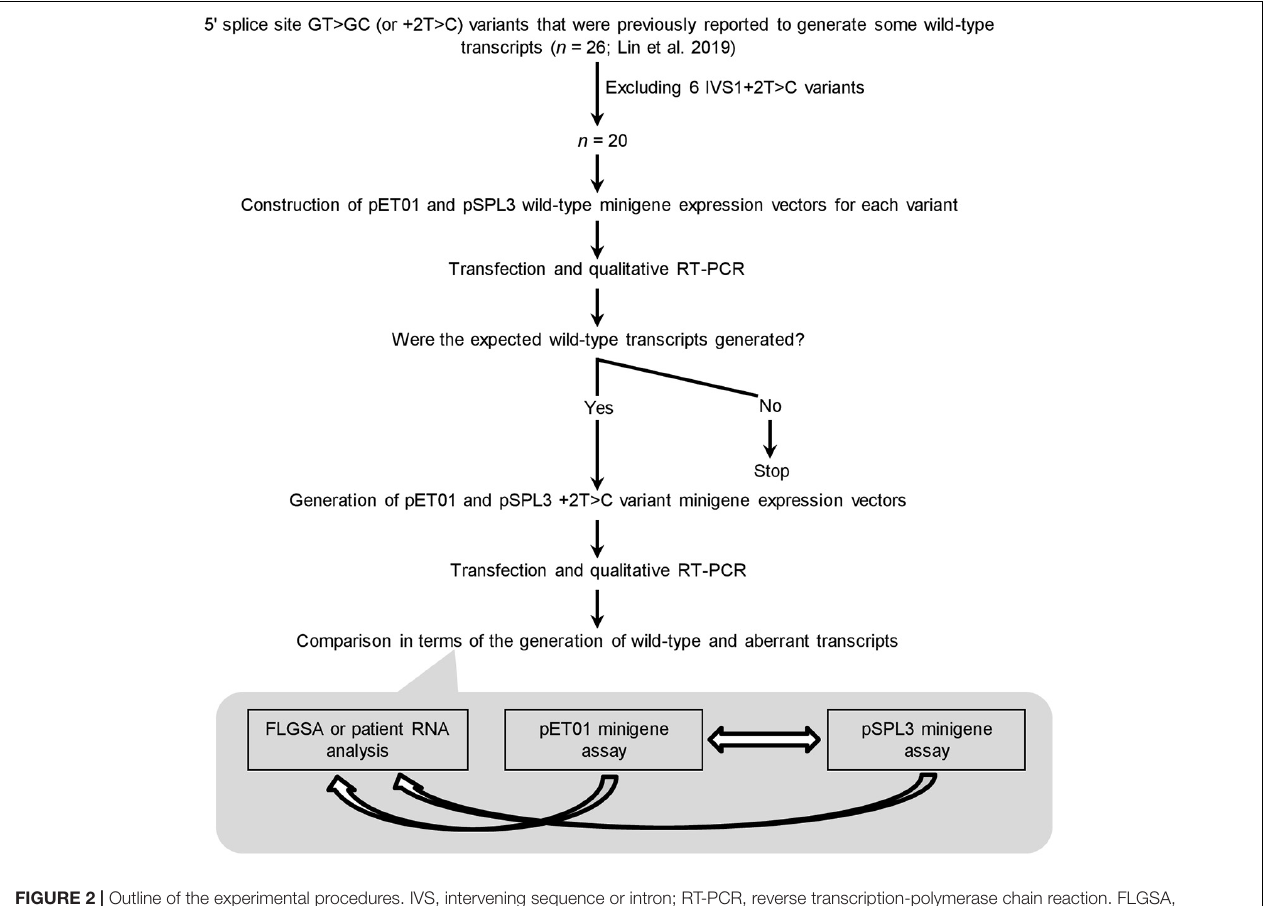
FIGURE 2 | Outline of the experimental procedures. IVS, intervening sequence or intron; RT-PCR, reverse transcription-polymerase chain reaction. FLGSA, full-length gene splicing